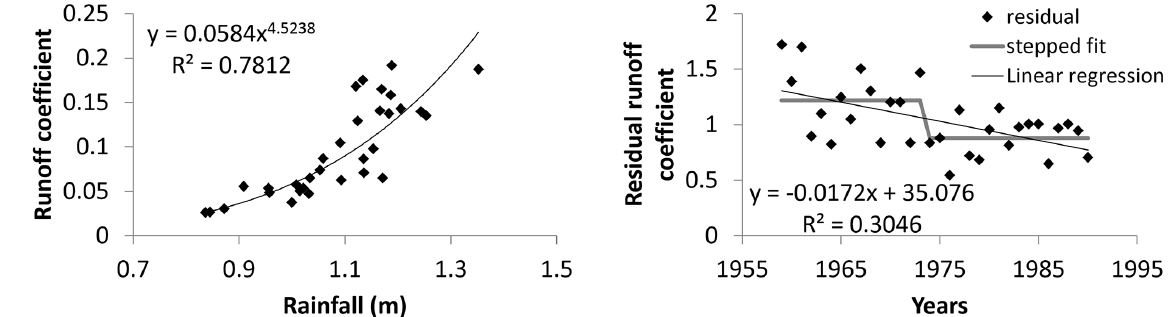
Figure 1. Variation in runoff coefficient with annual rainfall amount and